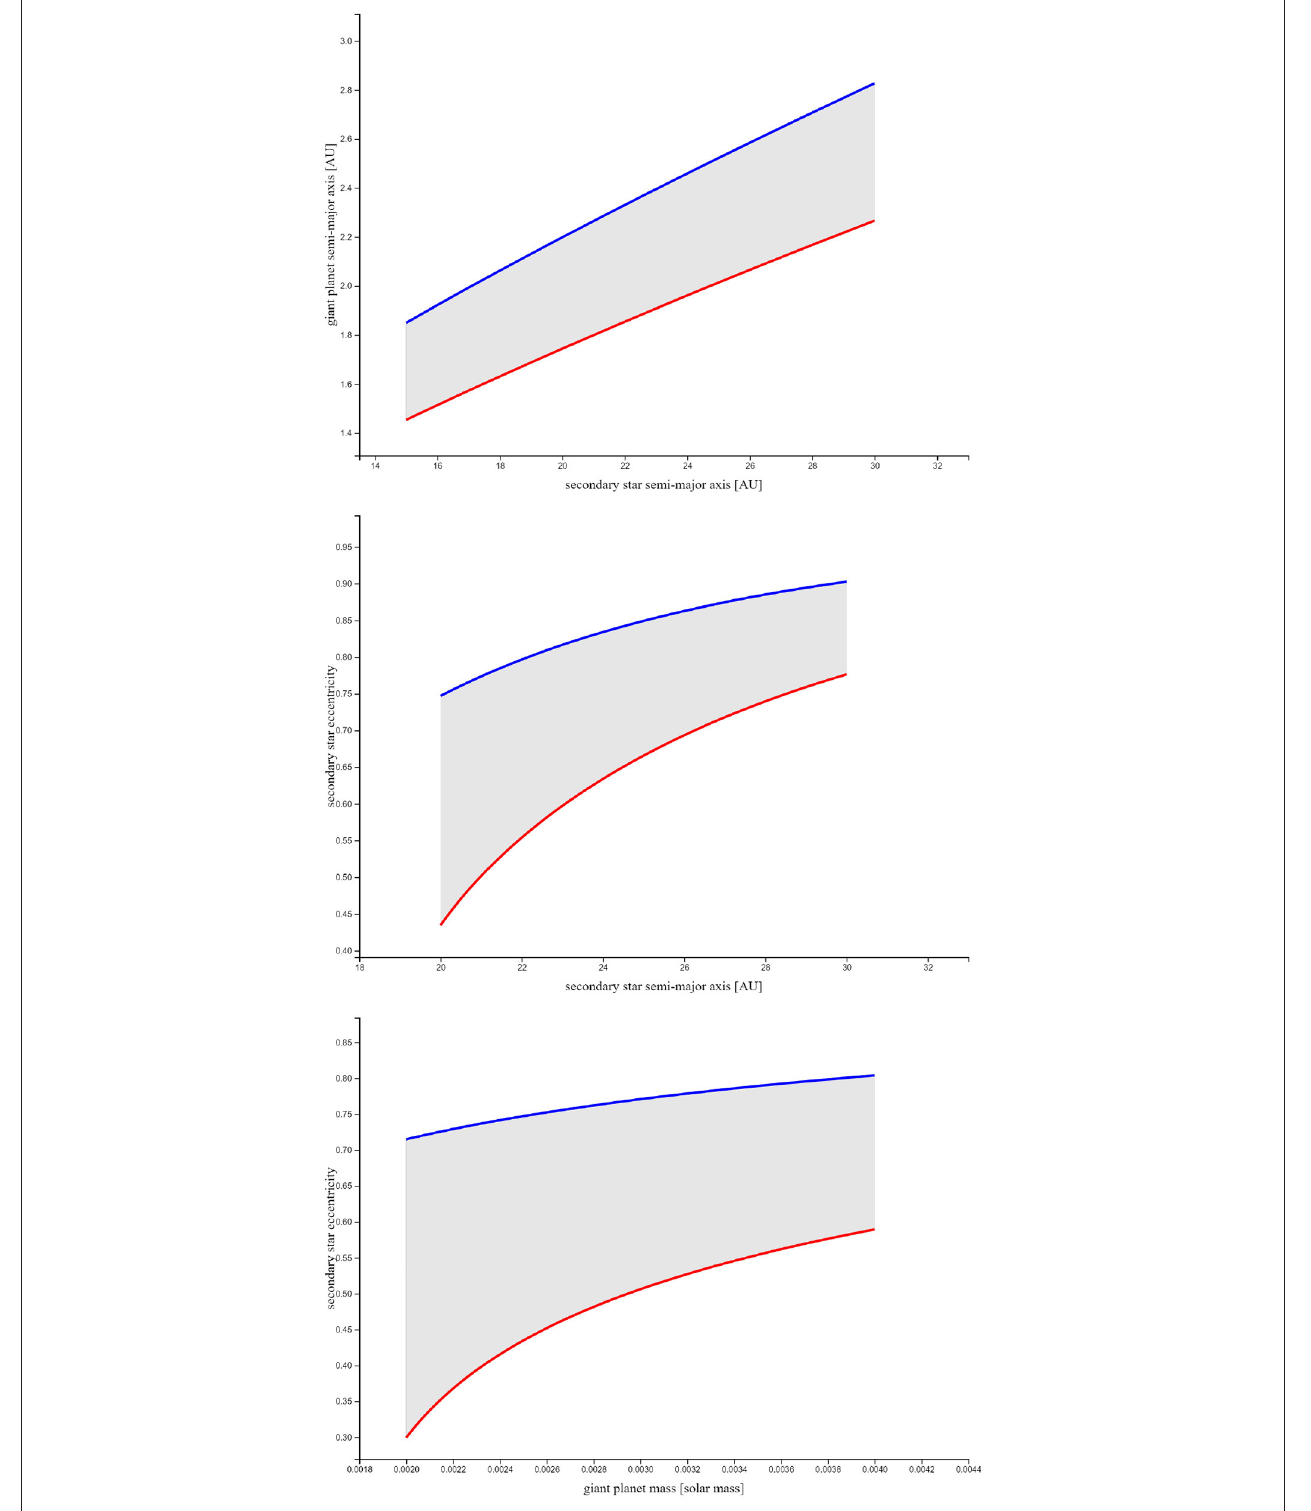
FIGURE 7 | Results for HD41004AbB. The gray stripe in each panel indicates conditions that cause perturbations in the primary’s HZ due to an SR. The top panel shows the result for the semi-major axis of the secondary star (x-axis) and the giant planet (y-axis). In the middle panel the y-axis shows the binary’s eccentricity. In the bottom panel, the x-axis shows the giant planet’s